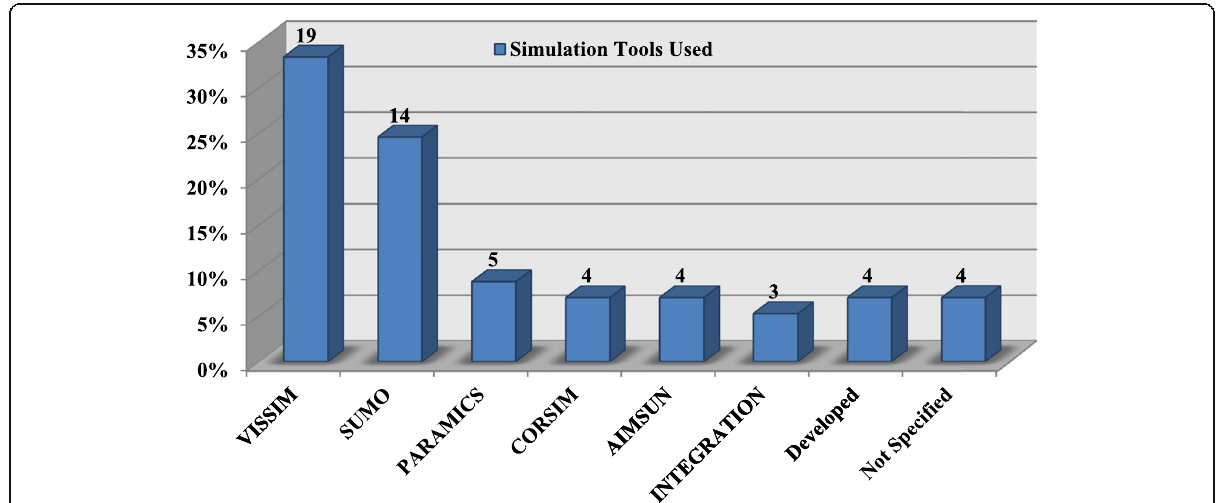
Fig. 2 Number of publications utilizing microsimulation